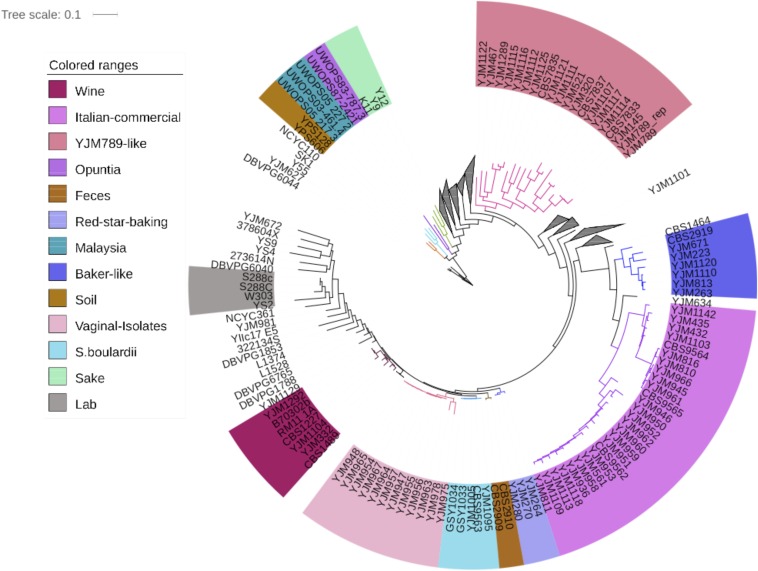
Neighbor-joining tree of 144 sequenced strains and 35 Liti et al. (2009) strains, based on SNP differences within the S. cerevisiae genome. Groups of strains that fall within a cluster containing noncommercial strains from a single known source are highlighted in color blocks. Clades containing only clinical strains without a known source are collapsed, with the full tree available in Figure 4.